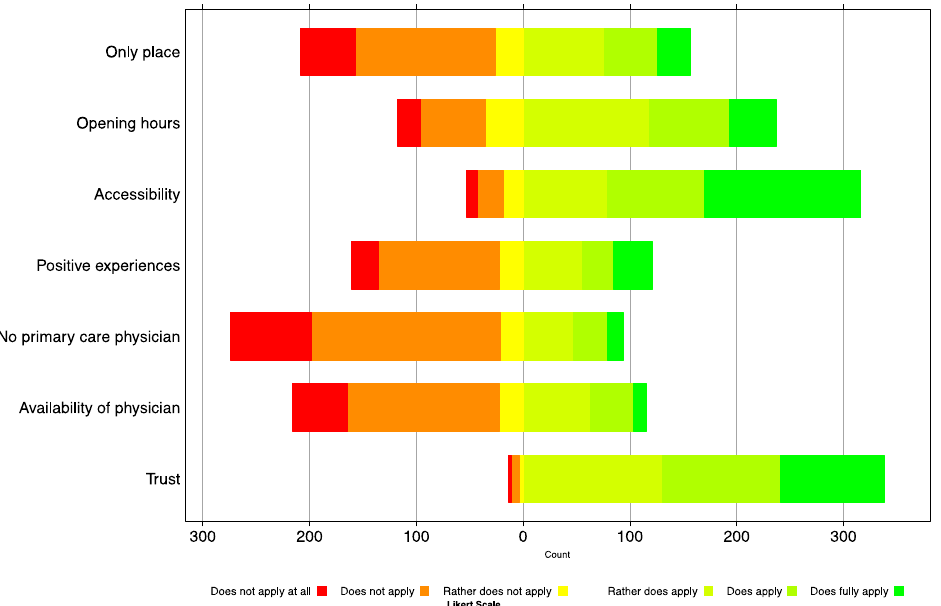
Figure 1. Frequency distribution of the answers on the reasons for choosing a pharmacy in the canton of Zurich as a place for getting vaccinated against COVID-19 (N = 372). A Likert scale of 6 + 1 was used, whereby “not answerable” was excluded.